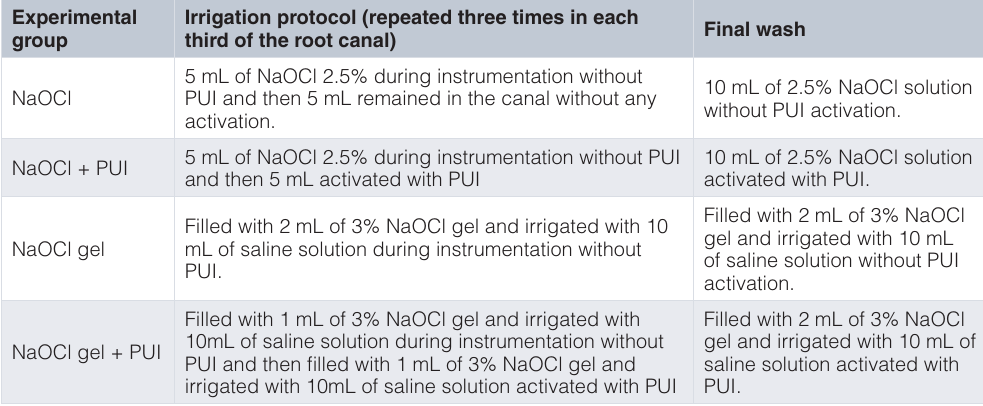
Table 1. Protocols for experimental groups. NaOCL, sodium hypochlorite; PUI, passive ultrasonic irrigation. Experimental